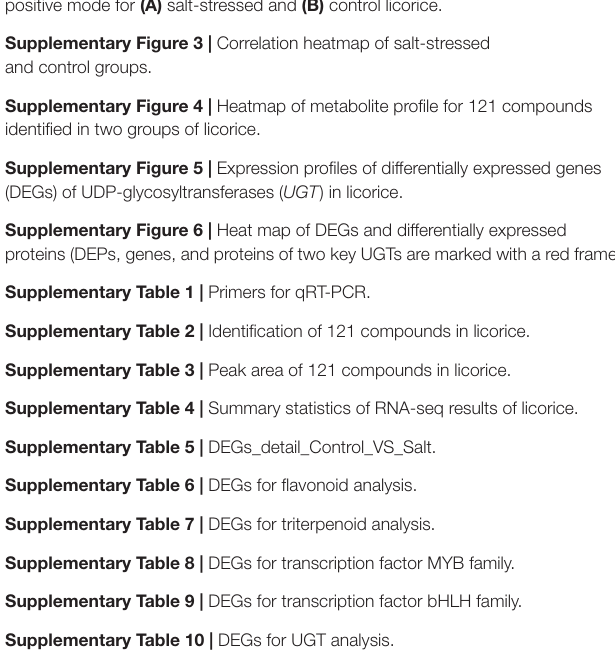
Supplementary Figure 3 | Correlation heatmap of salt-stressed and control groups. Supplementary Figure 4 | Heatmap of metabolite profile for 121 compounds identified in two groups of licorice. Supplementary Figure 5 | Expression profiles of differentially expressed genes (DEGs) of UDP-glycosyltransferases ( UGT ) in licorice. Supplementary Figure 6 | Heat map of DEGs and differentially expressed proteins (DEPs, genes, and proteins of two key UGTs are marked with a red frame. Supplementary Table 1 | Primers for qRT-PCR. Supplementary Table 2 | Identification of 121 compounds in licorice. Supplementary Table 3 | Peak area of 121 compounds in licorice. Supplementary Table 4 | Summary statistics of RNA-seq results of licorice. Supplementary Table 5 | DEGs_detail_Control_VS_Salt. Supplementary Table 6 | DEGs for flavonoid analysis. Supplementary Table 7 | DEGs for triterpenoid analysis. Supplementary Table 8 | DEGs for transcription factor MYB family. Supplementary Table 9 | DEGs for transcription factor bHLH family. Supplementary Table 10 | DEGs for UGT